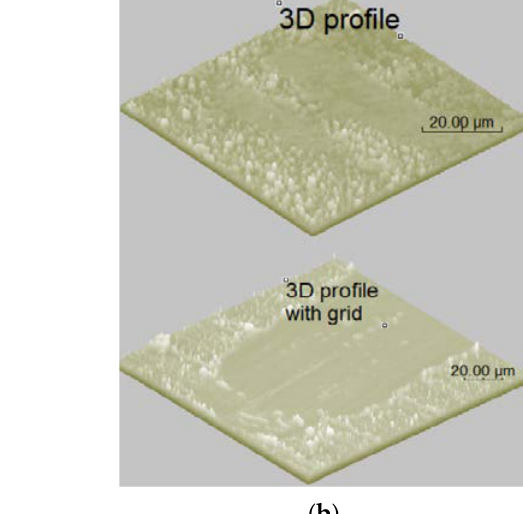
Table 10. Chemical composition of the areas selected in Figure 3a in wt and at%.